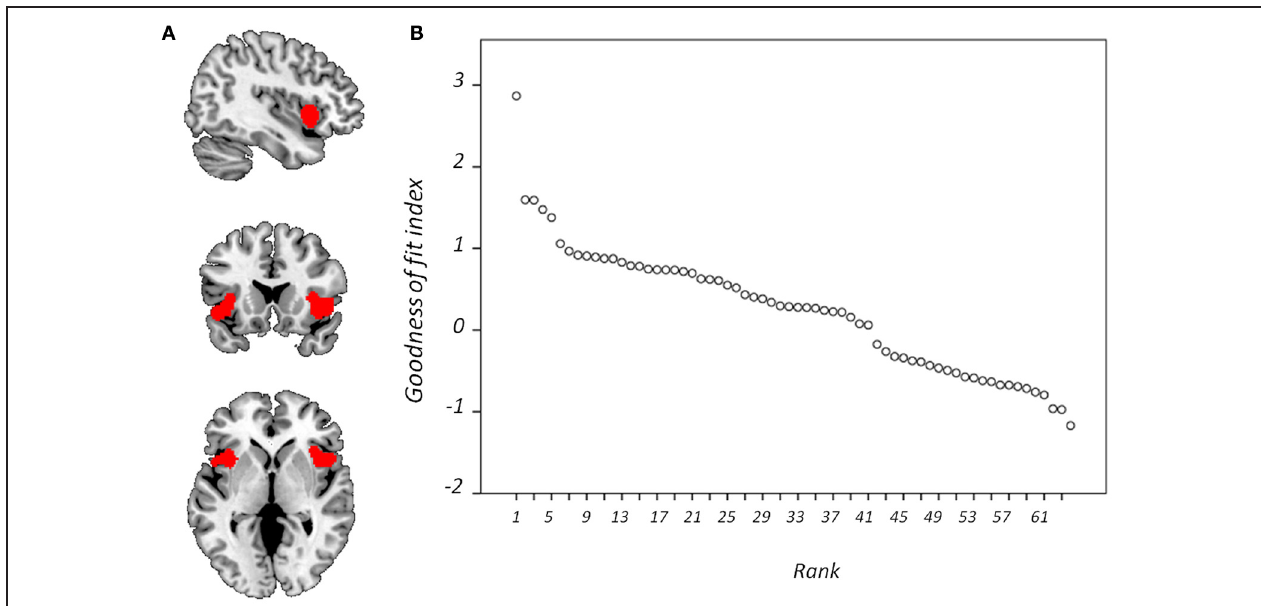
FIGURE 4 | Goodness-of-fit (GOF) with frontoinsular cortex mask. Showing (A) the mask is overlaid onto a standardized T 1 -weighted image shown according to the neurological convention; and (B) GOF with this mask for each component displayed according to rank.